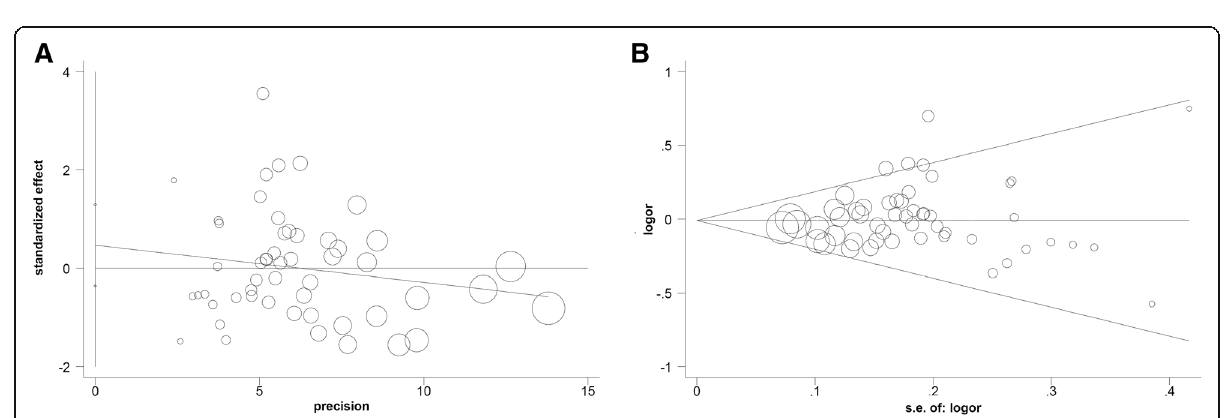
Fig. 3 Funnel plot of publication bias analysis. a Egger ’ s test; b Begg ’ s